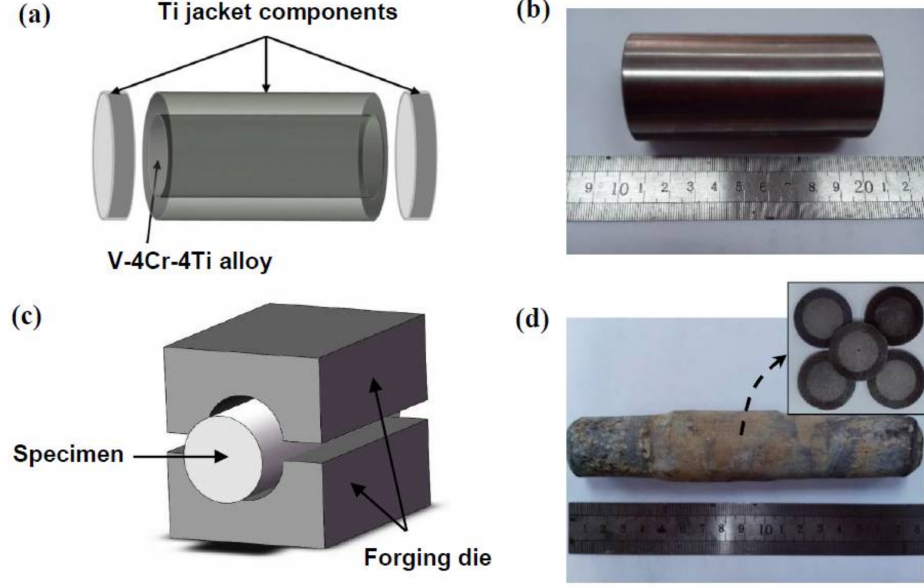
Figure 1. Schematic diagrams illustrating the specimen preparation and hot forging process: ( a ) the assembly of materials; ( b ) the assembled piece prior to forging; ( c ) the geometry of hot forging; ( d ) the assembled piece after